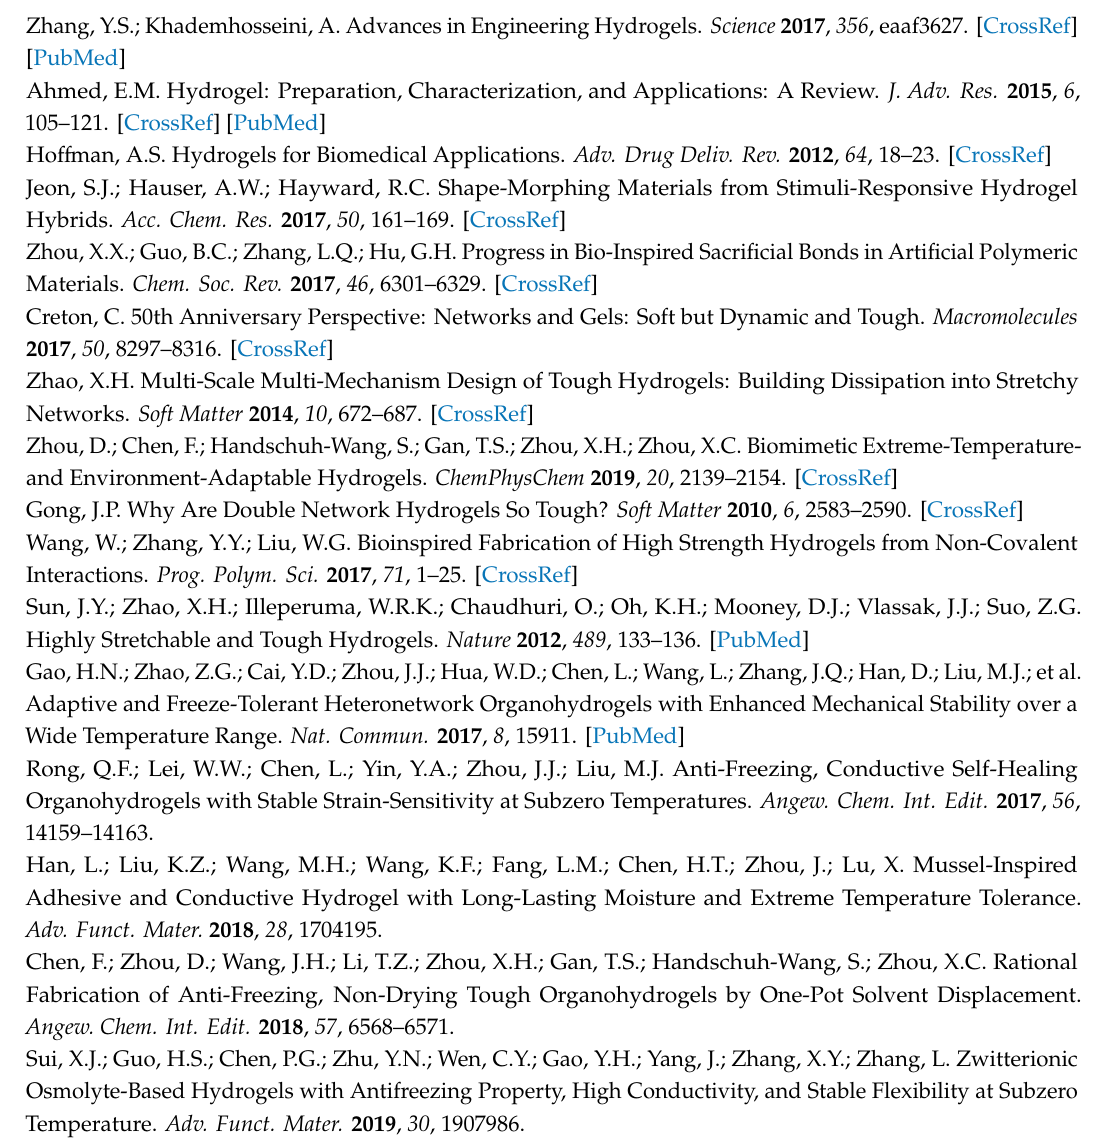
Figure S1: The swelling ratios of the PAAm hydrogel in the glycerol–water binary solvent with various glycerol fraction; Figure S2: The digital photograph of the PAAm gels from the solvent displacement after stored at − 40 ◦ C for 24 h; Figure S3: The experimental DSC results of the PAAm gels with various glycerol contents; Figure S4: The remaining weight ratio of the PAAm gels after heating to the initial PAAm hydrogels; Figure S5: The swelling ratios of the PAAm hydrogel in the EG–water binary solvent with various EG fraction; Figure S6: The swelling ratios of the gelatin hydrogel in the glycerol–water binary solvent with various glycerol